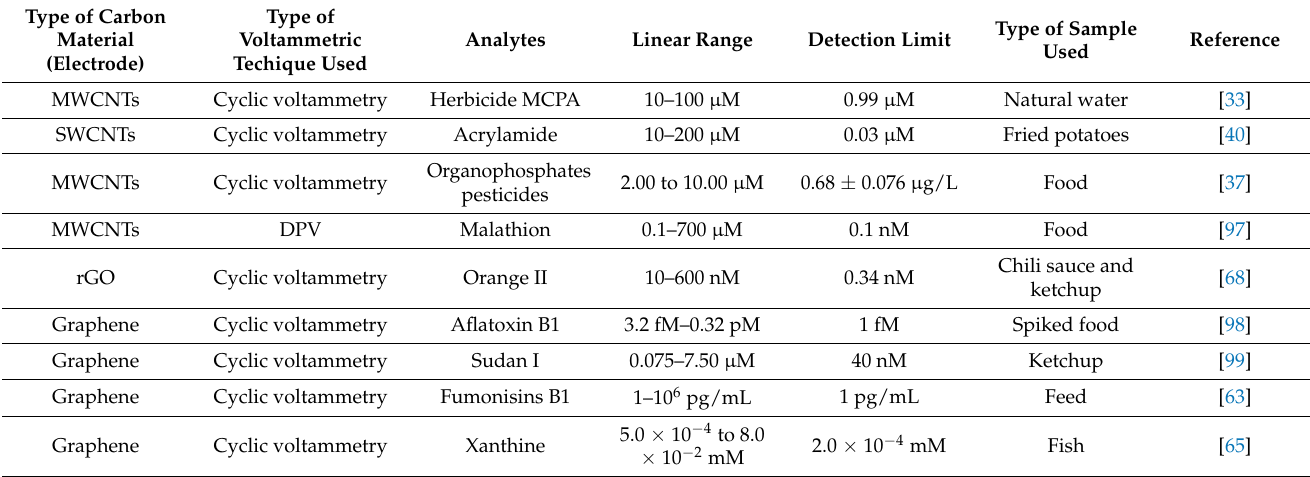
Table 1. Carbon material-based nanocomposites as electrochemical sensors for food